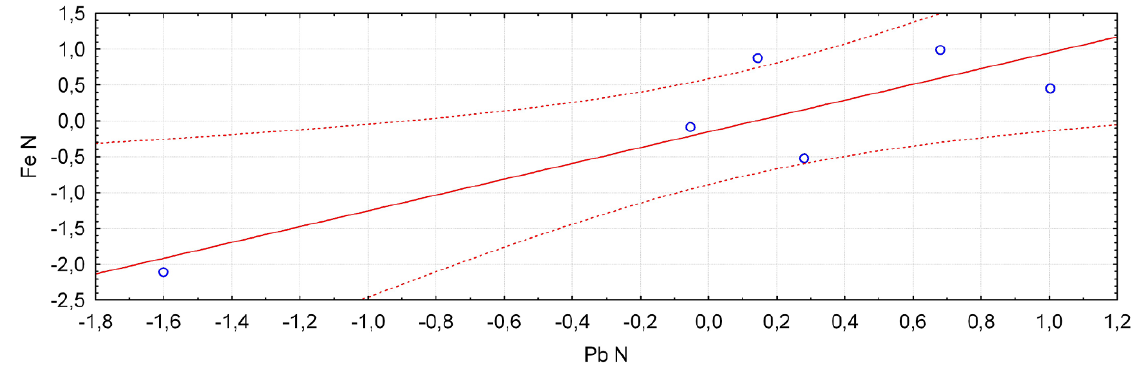
Figure 3. Data dispersion at Fe N and Pb N